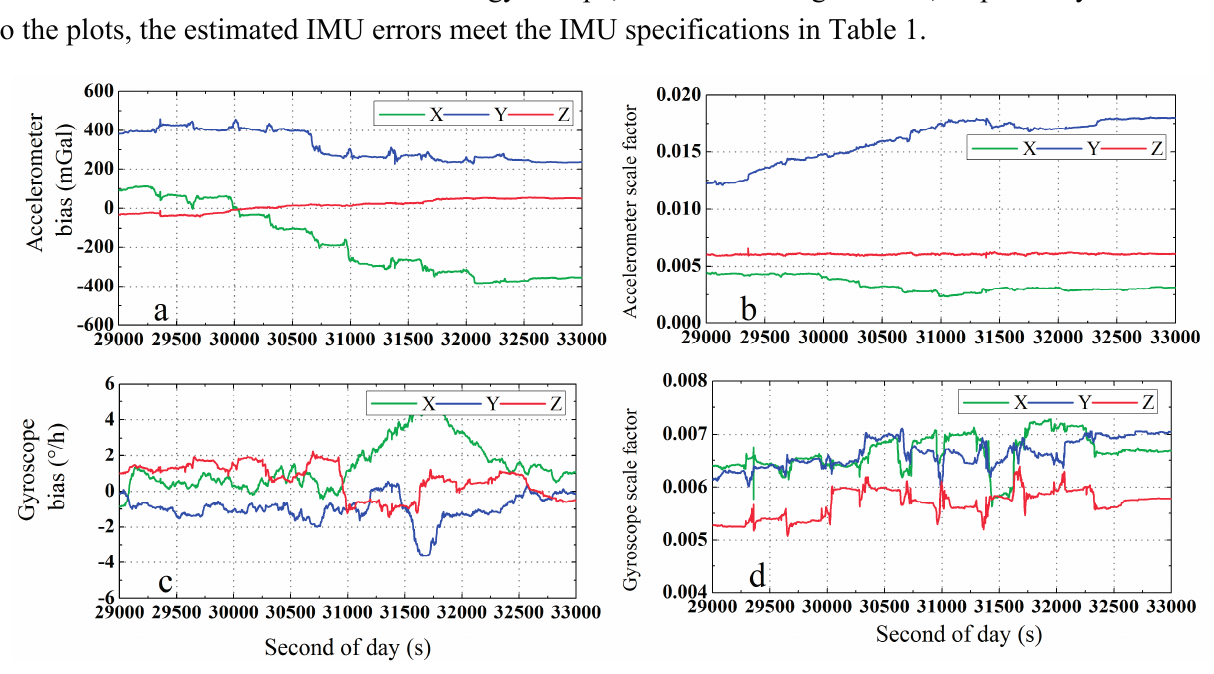
Figure 6. Estimated biases and scale factors of the POS310 IMU in the directions of the b -frame axes: accelerometer biases ( a ) and scale factors ( b ), gyroscope biases ( c ) and scale factors ( d